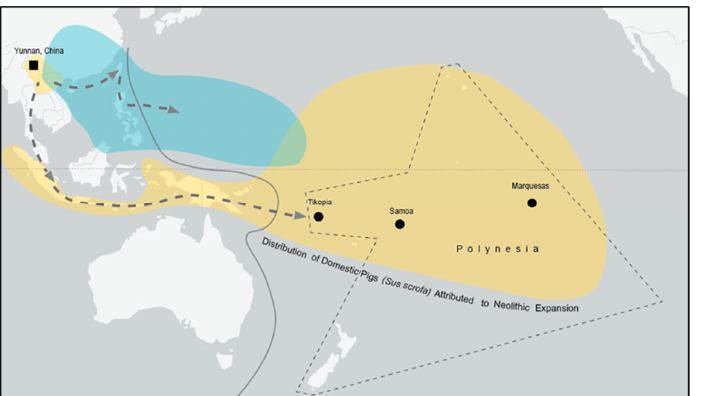
Figure 1. The origins of domesticated pigs in Polynesia. The “Pacific Clade” (yellow) of pig mtDNA is found in northern peninsular Southeast Asia, island Southeast Asia, Near Oceania (west of solid line) and Remote Oceania (east of solid line). Globally, only 43 modern and 9 ancient pigs have been definitively classified as Pacific Clade. This includes examples of domestic and wild/feral pigs. All other Oceanic pigs belong to a separate “East Asian Clade” (blue).